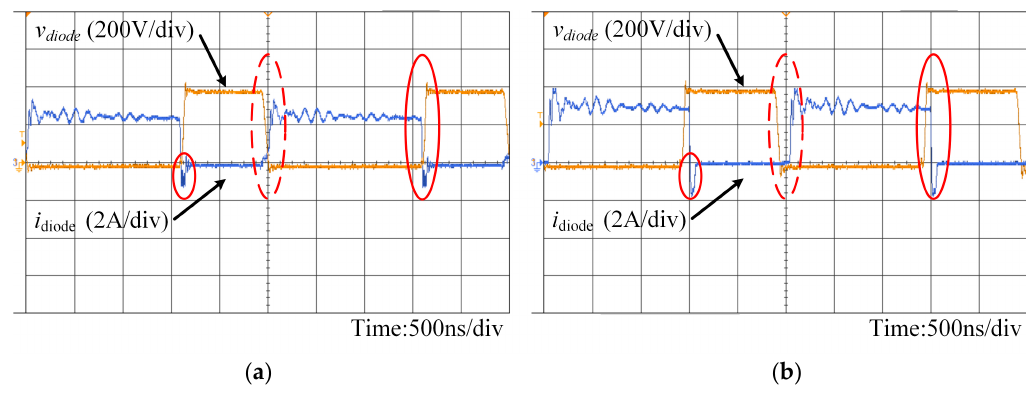
Figure 21. Voltage and current waveforms of the free-wheeling diode D 1 : ( a ) switching transition of SiC diode; and ( b ) switching transition of Si diode.